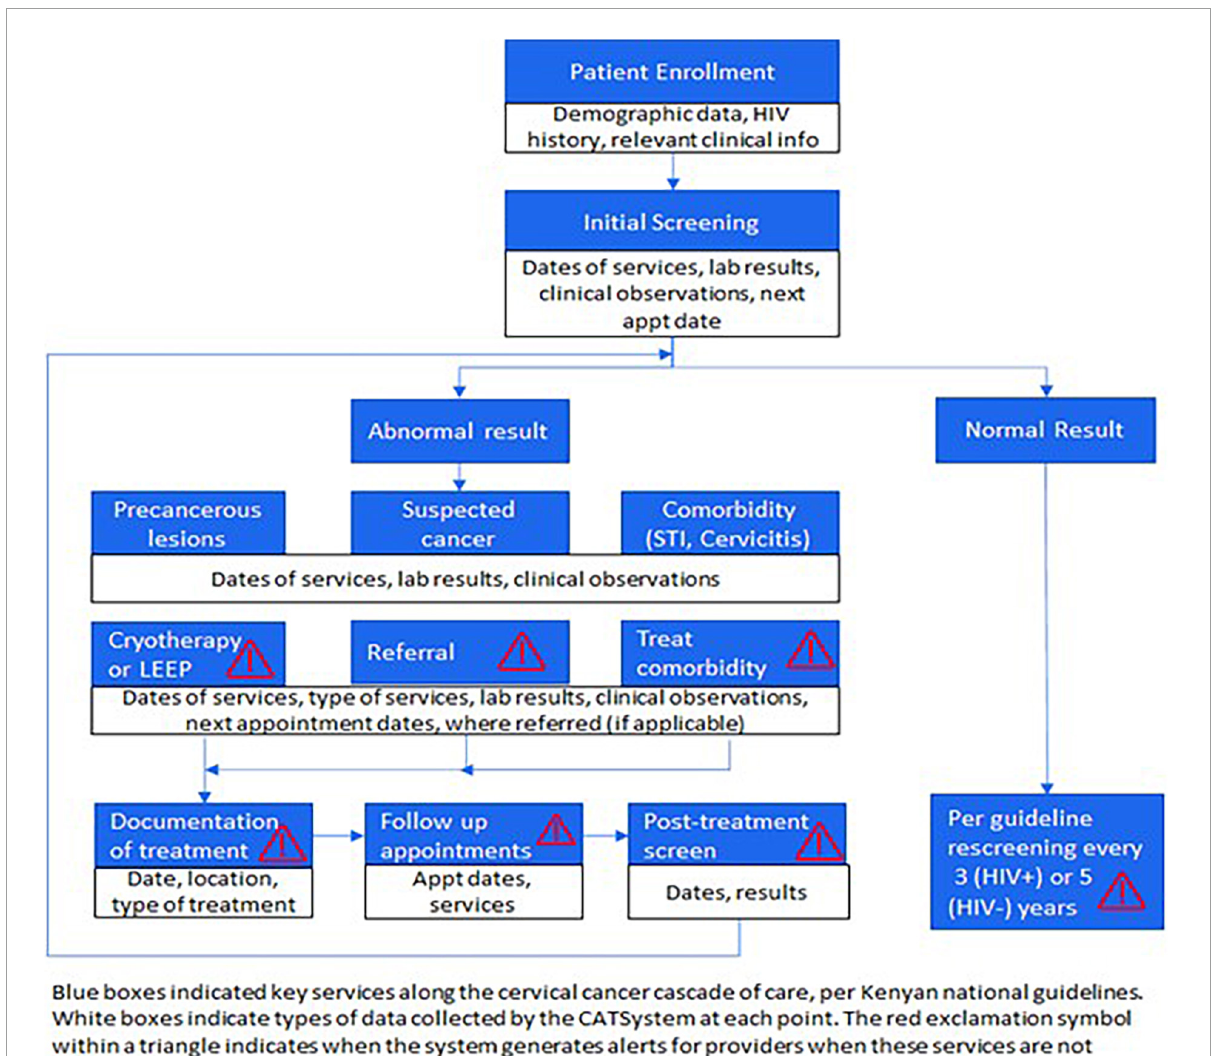
FIGURE1 Kenya ministry of health national cervical cancer screening